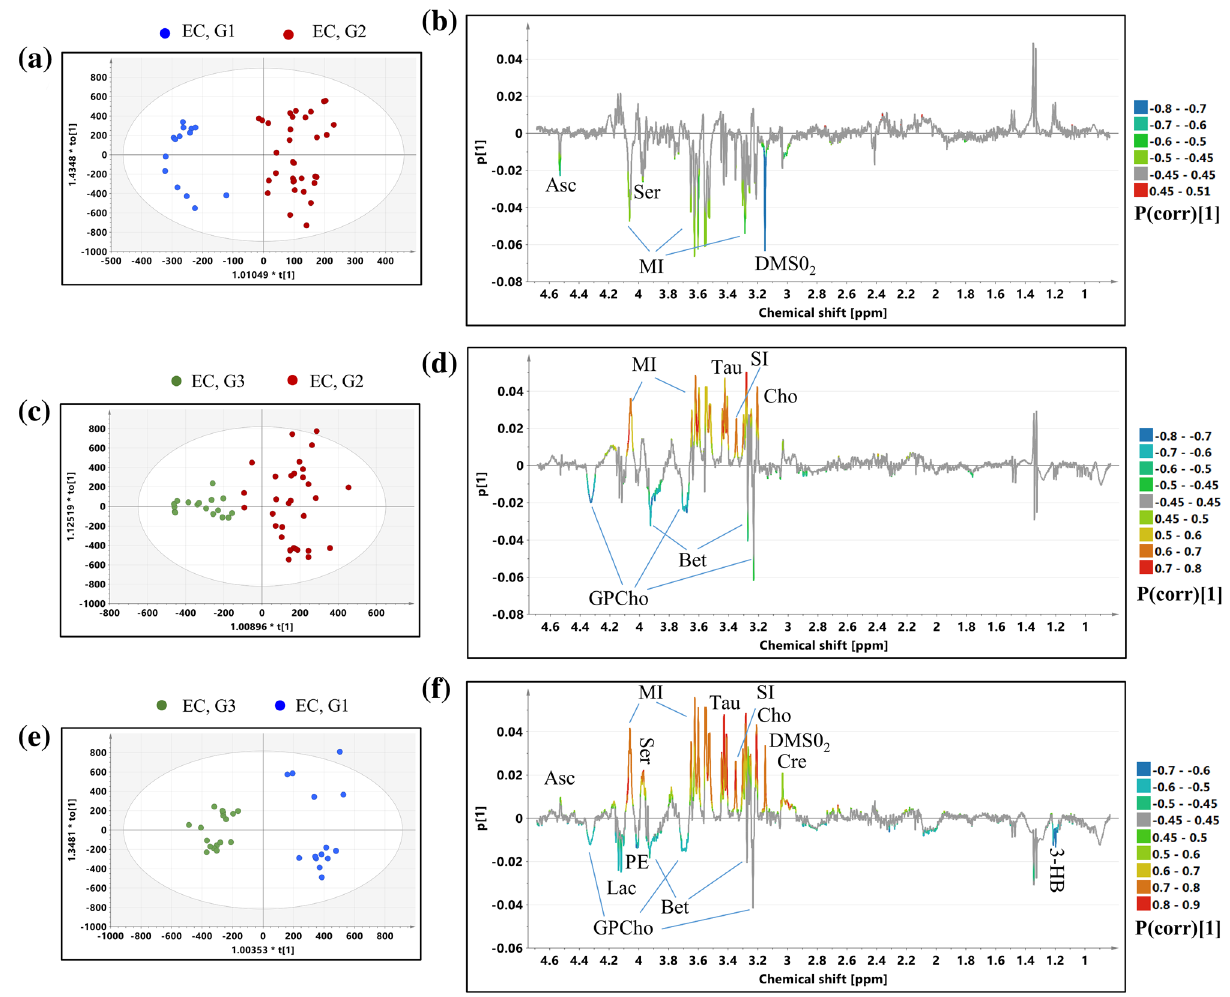
Figure 6. Results obtained from the OPLS-DA models: ( a ) the scores plot and ( b ) the loadings plot for the model 7, ( c ) the scores plot and ( d ) the loadings plot for the model 8, ( e ) the scores plot and ( f ) the loadings plot for the model 9. The color circles represent: blue dot—G1 EC, red dot—G2 EC, green dot—G3 EC. 3-HB 3-hydroxybutyrate, Cre creatine, GPCho glycerophosphocholine, Cho choline, DMSO 2 dimethyl sulfone, SI scyllo-inositol, Tau taurine, MI myo-inositol, PE phoshoethanolamine, Ser serine, Bet betaine, Asc ascorbate. The image was created using SIMCA-P 15.0 software package (https:// www. sarto rius.